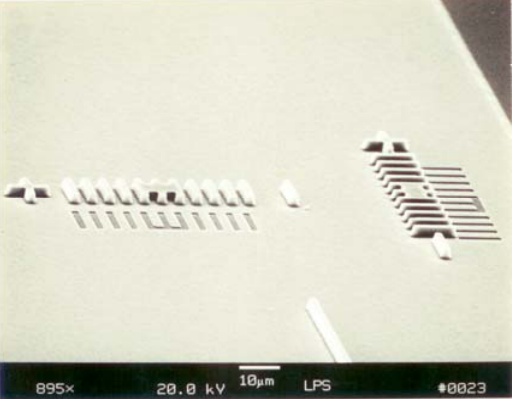
Figure 6. Verniers for different layer alignments